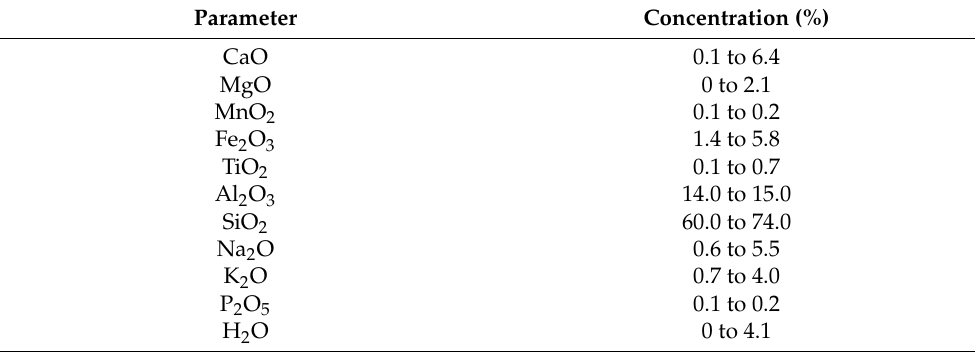
Table 1. Material properties of natural zeolite.